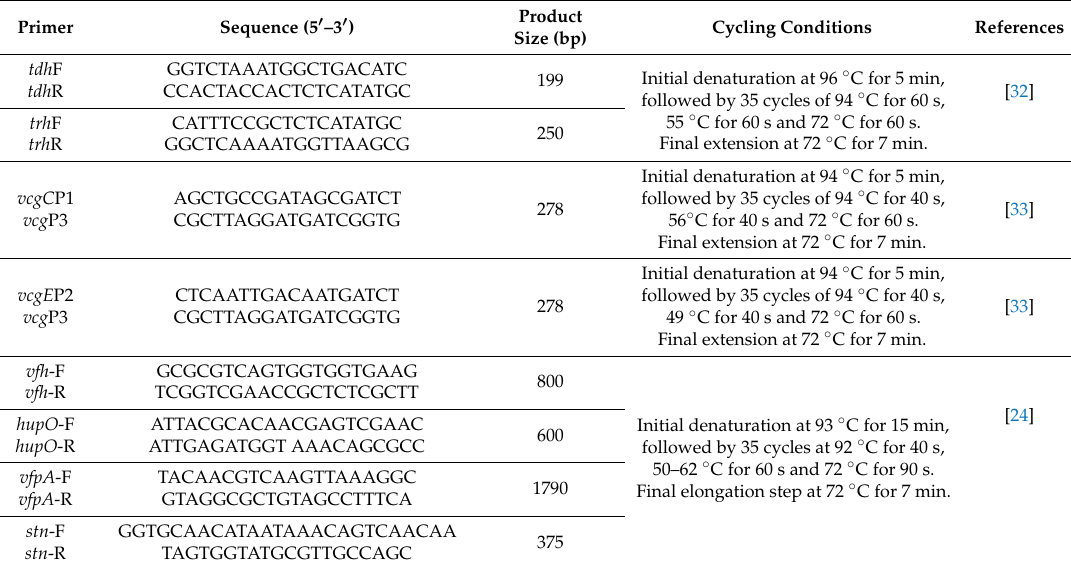
Table 2. Primer sets used in the detection of Vibrio virulence